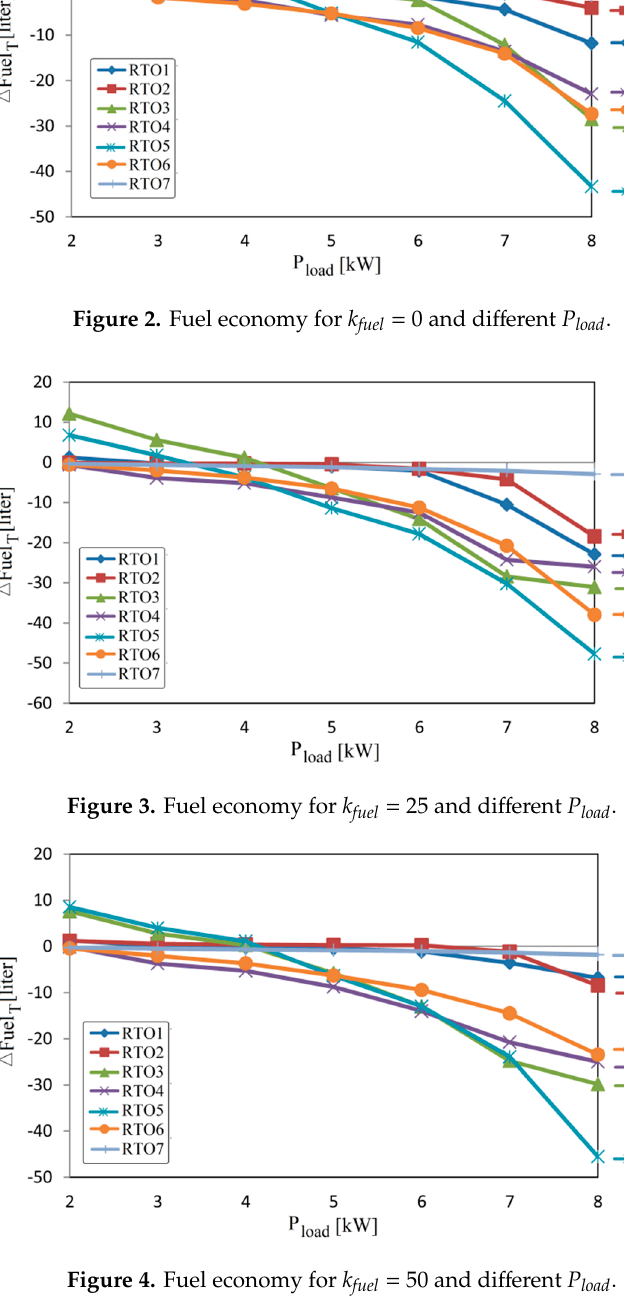
Figure 4. Fuel economy for k fuel = 50 and different P load .